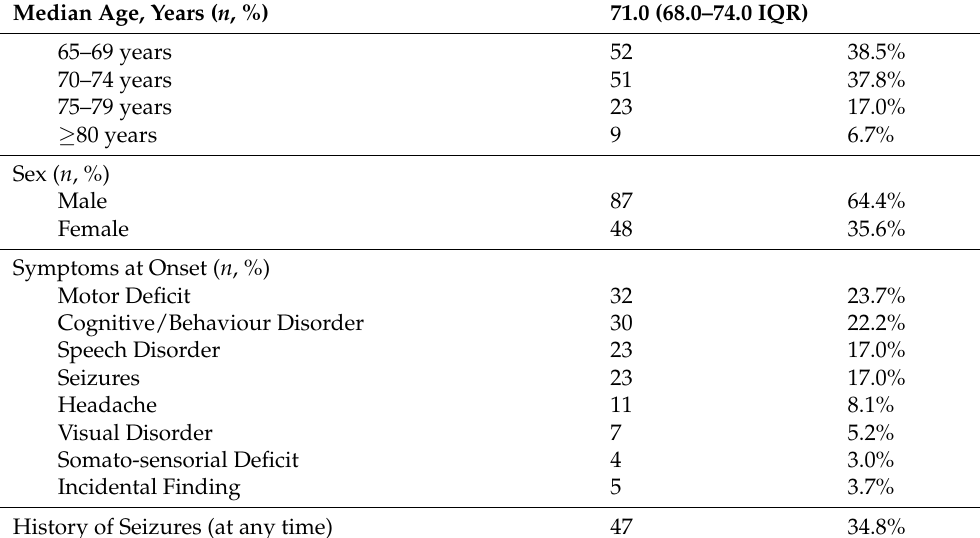
Table 1. Patient Characteristics ( n =